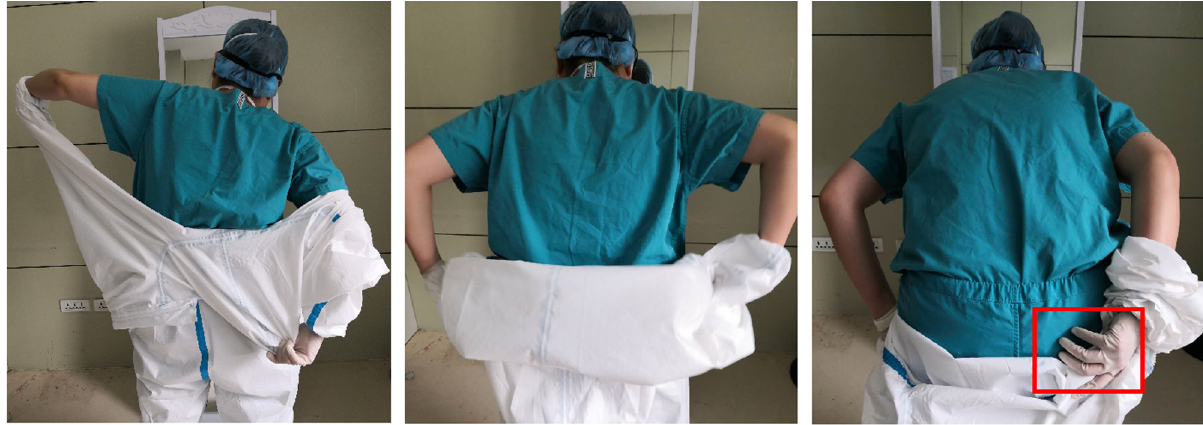
Figure 4: Representative images showing the vigorous movements during the removal of the disposable coverall suit, with the person ’ s gloved hand touching and contaminating the inner medical